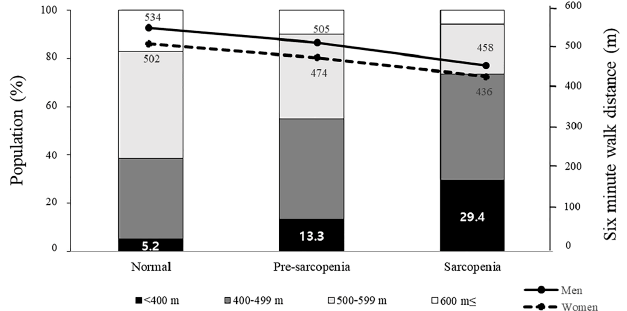
Figure 1. Six-minute walking distance according to sarcopenia group.